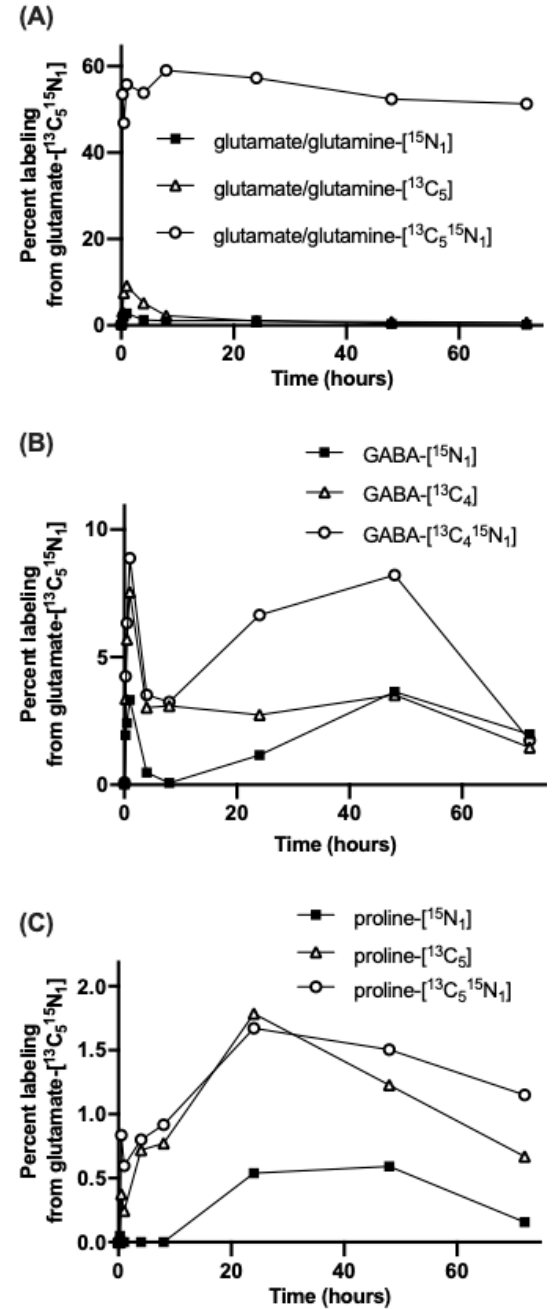
Figure 3. Time course of percent labeling of single- and double-labeled isotopic forms of glutamate/glutamine ( A ), GABA ( B ) and proline ( C ) from 4 mM glutamate-[ 13 C 515 N 1 ] applied to foliage of creeping bentgrass ( Agrostis stolonifera